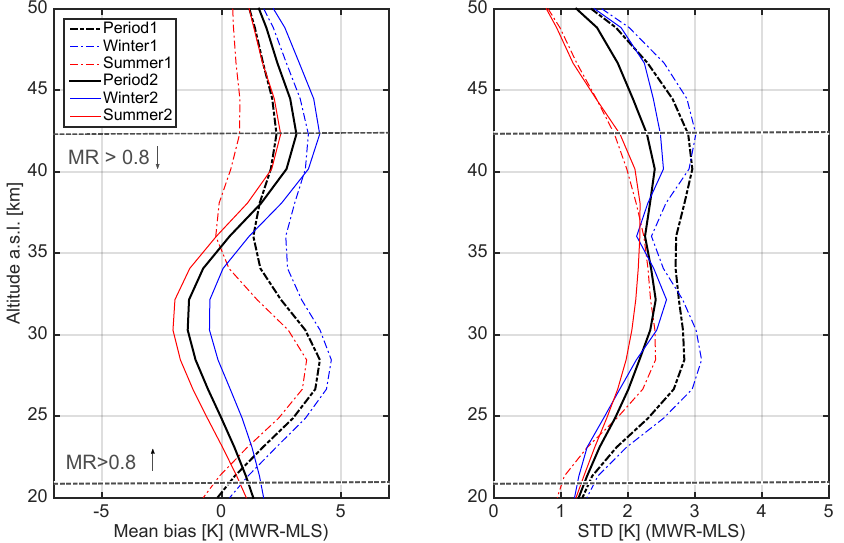
Figure 10. Mean temperature biases and standard deviations between TEMPERA and MLS. A total of 358 profiles have been compared (Period 1: 192 profiles, dash lines; Period 2: 166 profiles, solid lines). The mean and the standard deviations for each period are represented by black lines. The winter season is indicated with blue lines while the summer is indicated by red lines (Winter1: 103 profiles; Summer1: 89 profiles; Winter2: 67 profiles; Summer2: 99).